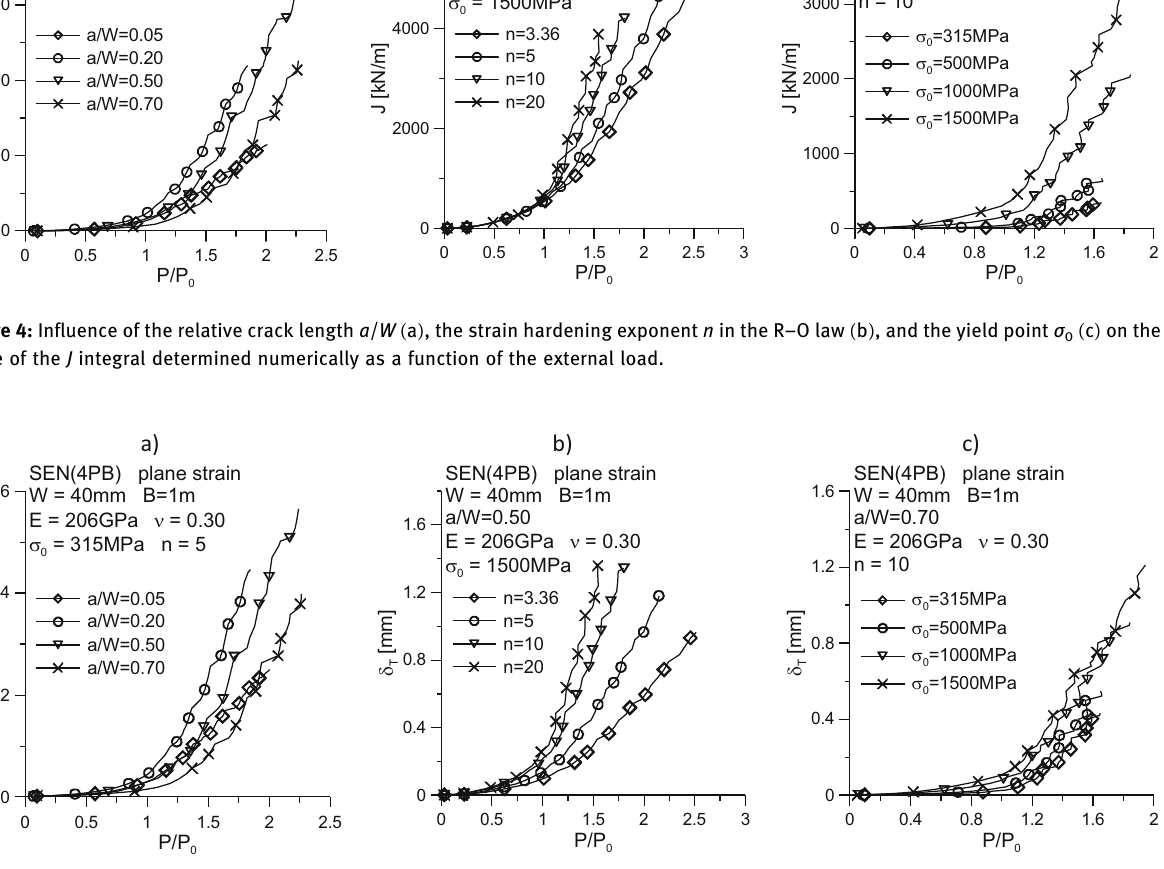
Figure 5: In fl uence of the relative crack length a / W ( a ) , the strain hardening exponent n in the R – O law ( b ) , and the yield point σ 0 ( c ) on the value of the crack tip opening displacement δ T determined on the basis of numerical calculations and the Shih method [ 16 ] as a function of external load.